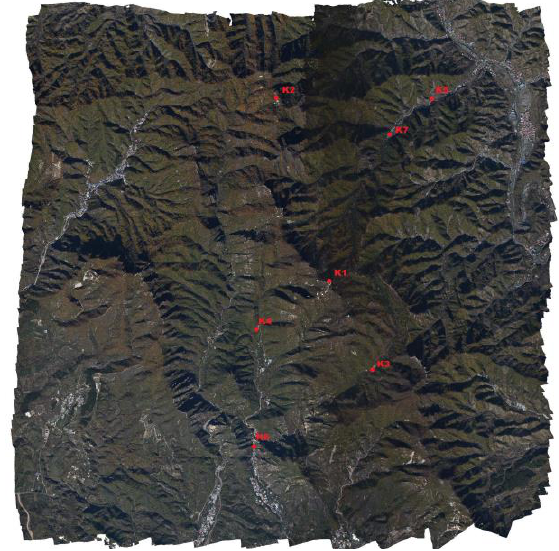
Figure 7. Positions of the GCPs The accuracy of the aerial triangulation at control points after the bundle block adjustment is given by Table 1. The maximum absolute Z error is 0.703m and the RMSE along Z axis is 0.278m. It can be seen that the vertical accuracy of the aerial triangulation is at the level of decimetres, which is accurate enough to evaluate the ASTER GDEM2 data. Table 1. The accuracy of the aerial triangulation on the GCPs